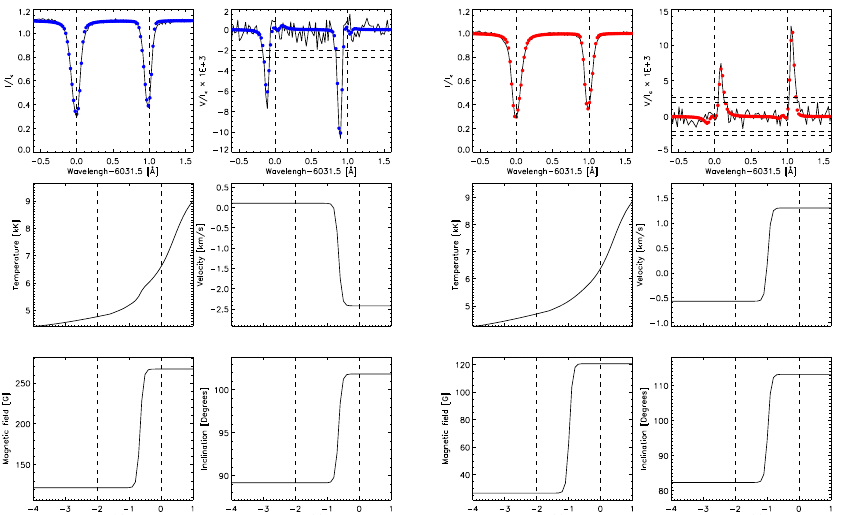
Fig. 3 Examples of single-lobed Stokes V profiles observed by Hinode in the quiet Sun at disk center. Blue-only profiles are shown on the left and red-only profiles on the right. Top: Stokes I and V profiles of the Fe i line pair at 630 nm (solid lines) and best-fit profiles computed with SIRJUMP (dots). Middle and bottom: Atmospheric stratifications resulting from a SIRJUMP inversion of the observed profiles (temperature, LOS velocity, magnetic field strength, and field inclination). Note the discontinuities around log τ 500 = − 0 . 9, well within the line formation region (indicated with vertical dashed lines). Images reproduced with permission from Sainz Dalda et al. (2012), copyright by